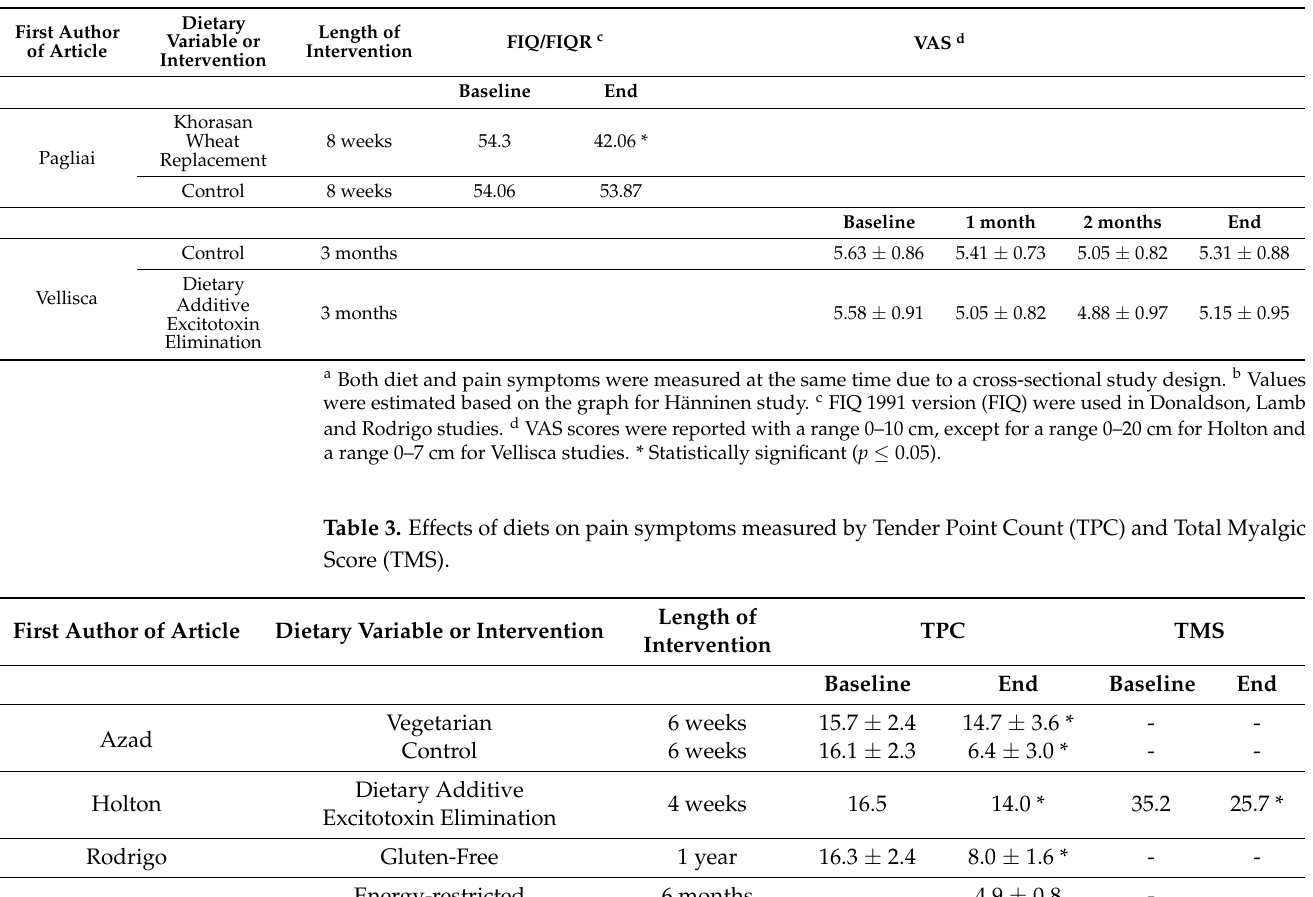
Abbreviations used: Dietary Inflammatory Index (DII), Fibromyalgia Impact Questionnaire (FIQ), fermentable oligo-, di- or mono-saccharides and polyols (FODMAP), Revised Fibromyalgia Impact Questionnaire (FIQR),